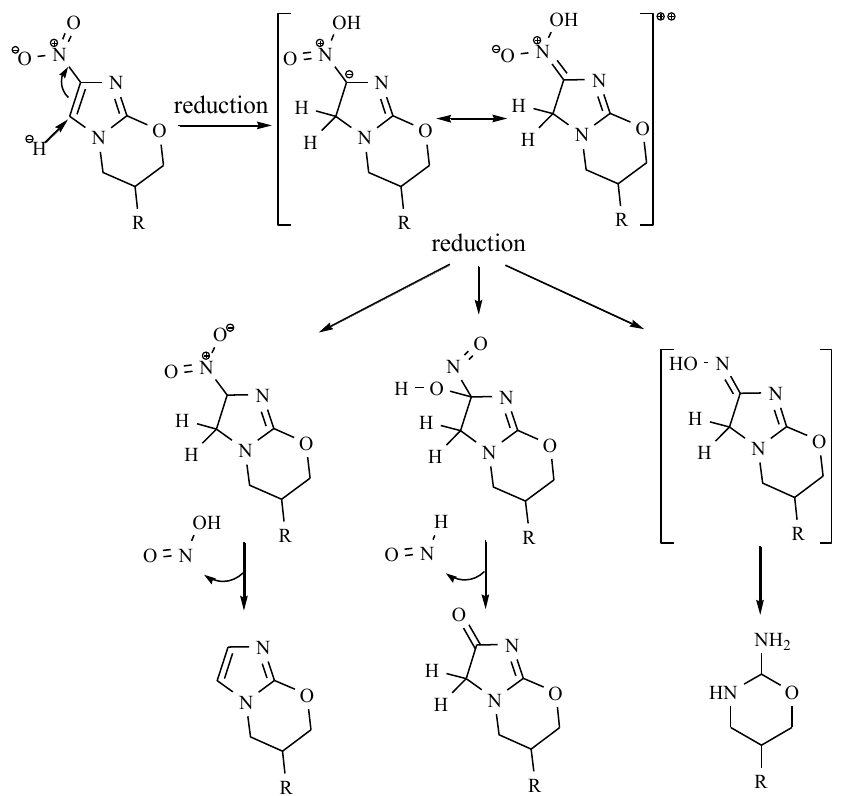
Scheme 2. The proposed mechanism for the anticubercular activity of PA-824